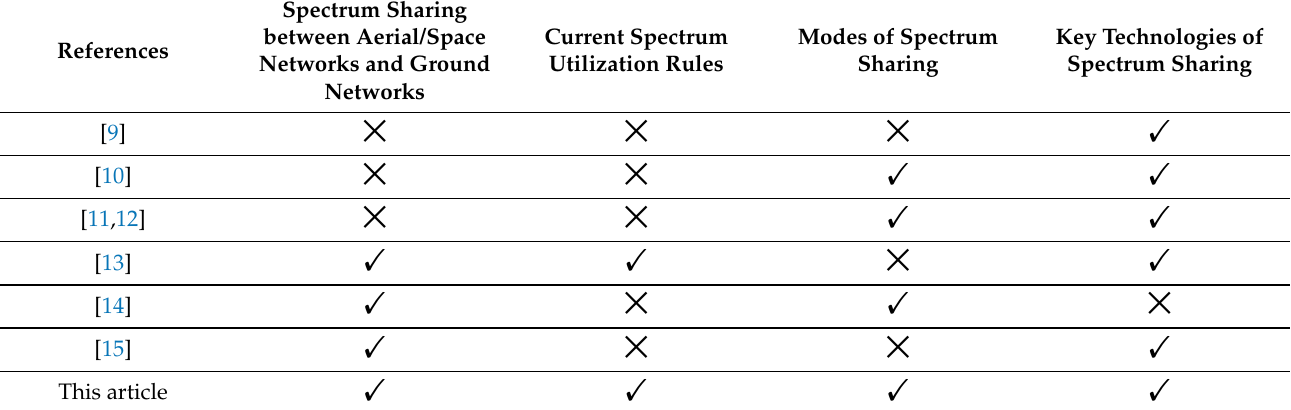
Table 1. Comparison of the related research